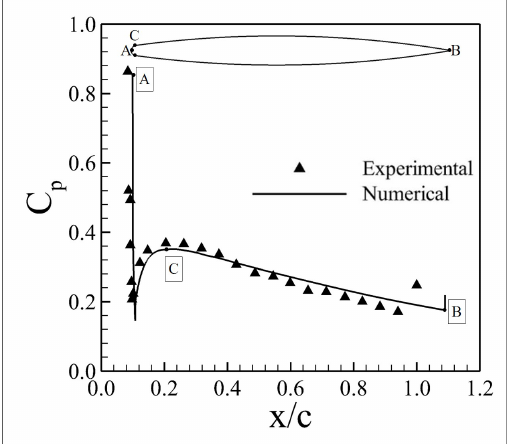
Figure 3. Surface Pressure Comparison and geometric configuration of R3015